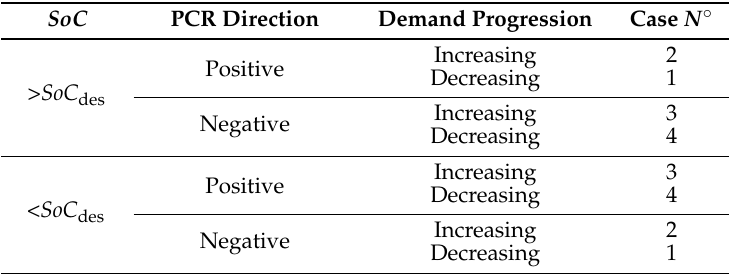
Table 2. Four case system for controlling the degrees of freedom (DoFs).